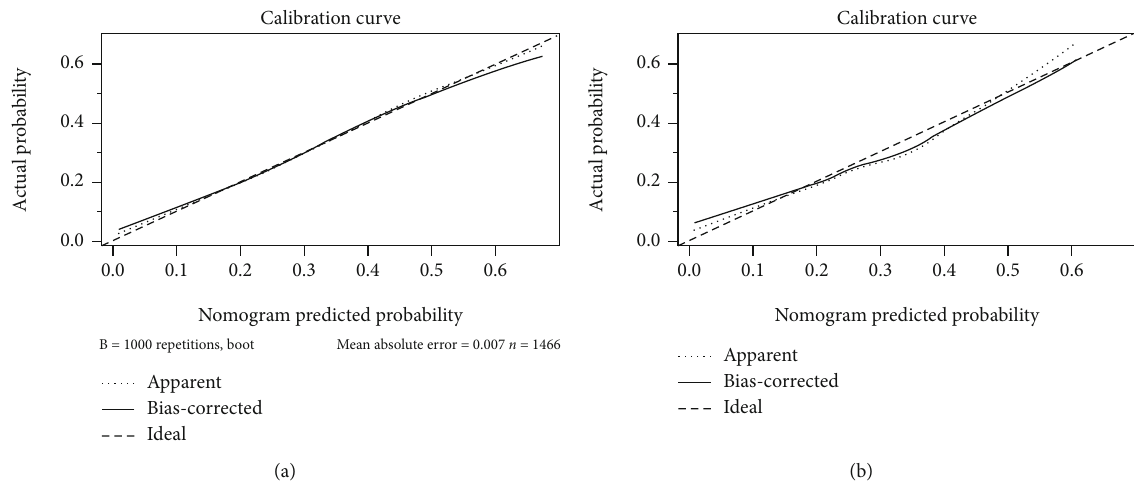
Figure 3: Calibration curve of nomogram-predicted and actual probability of long-time survivor in the training cohort ((a) N = 1466 ) and the validation cohort ((b) N = 584